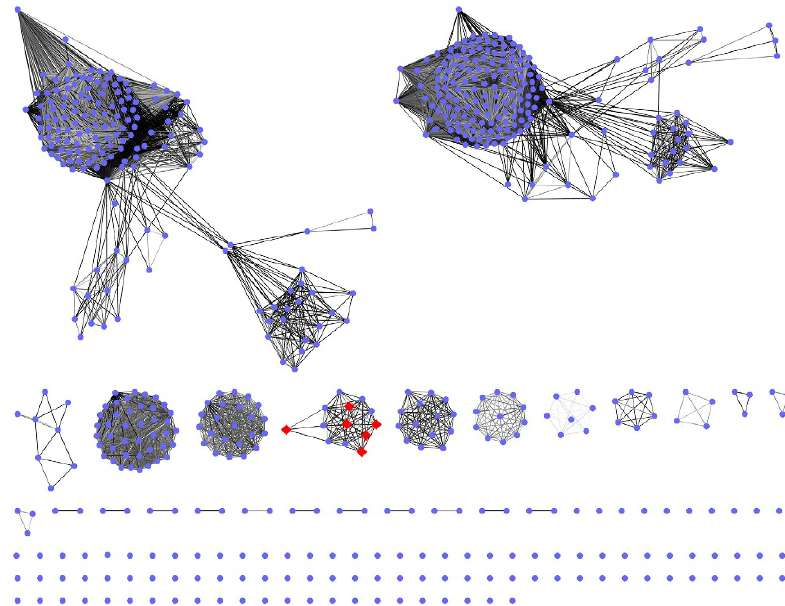
Figure 7 | Sequence similarity networks of c -GT homologues in Gram-positive actinobacteria. To our knowledge, none of these g -GT homologues (with an alignment score of 165) have been functionally characterized, with the exception of LmbA-like proteins (for example, LmbA, Ant6, Por11, SibY, TomL and HrmG, indicated by red diamonds) in this study. The s equence similarity networks are 95% representative node networks, that is, the sequences that share more than 95% identity are represented by a single node. The nodes that are not associated with Gram-positive actinobacteria were omitted